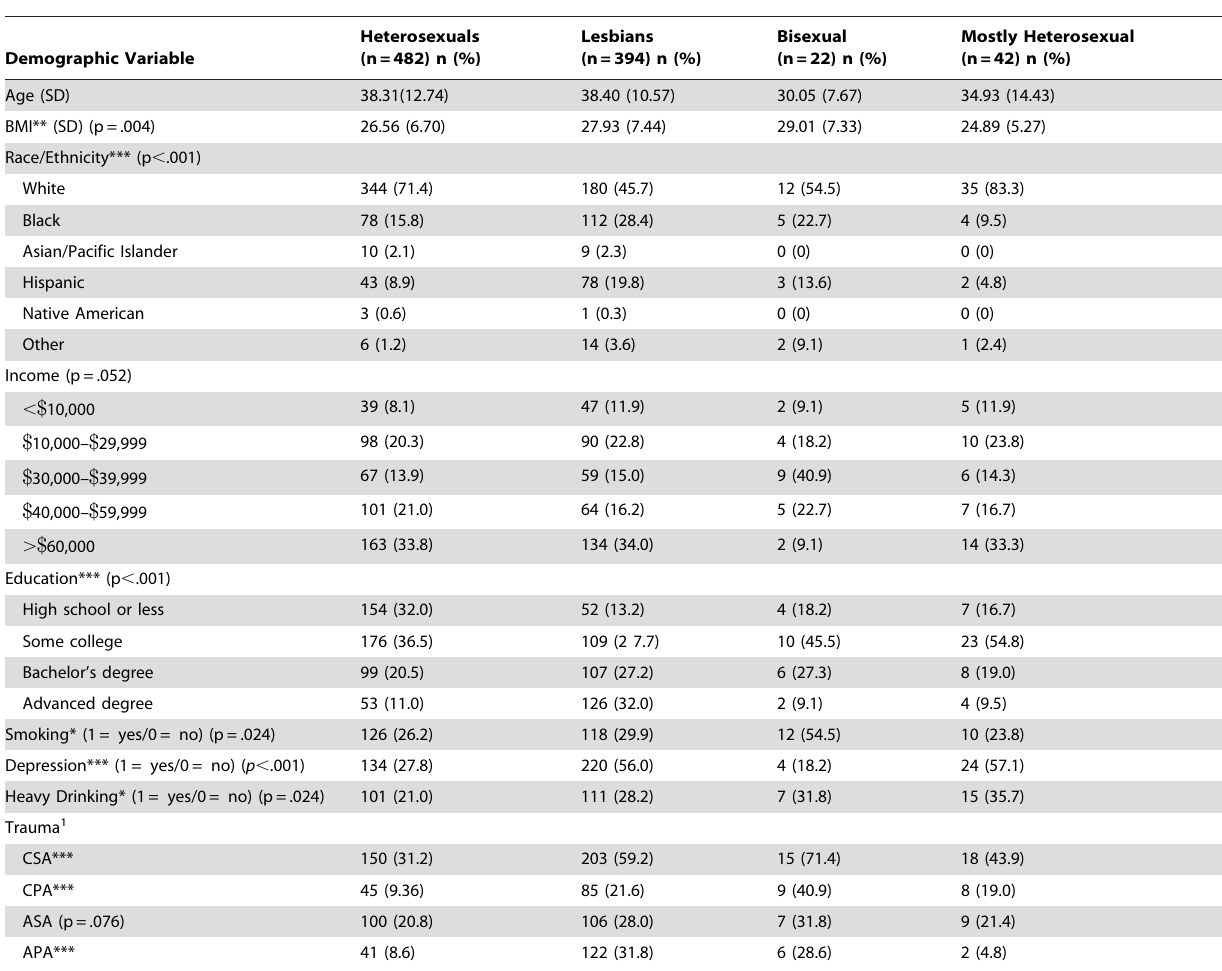
Table 1. Demographic and Prevalence of Victimization Experiences Comparison between Heterosexual and Lesbian Women.